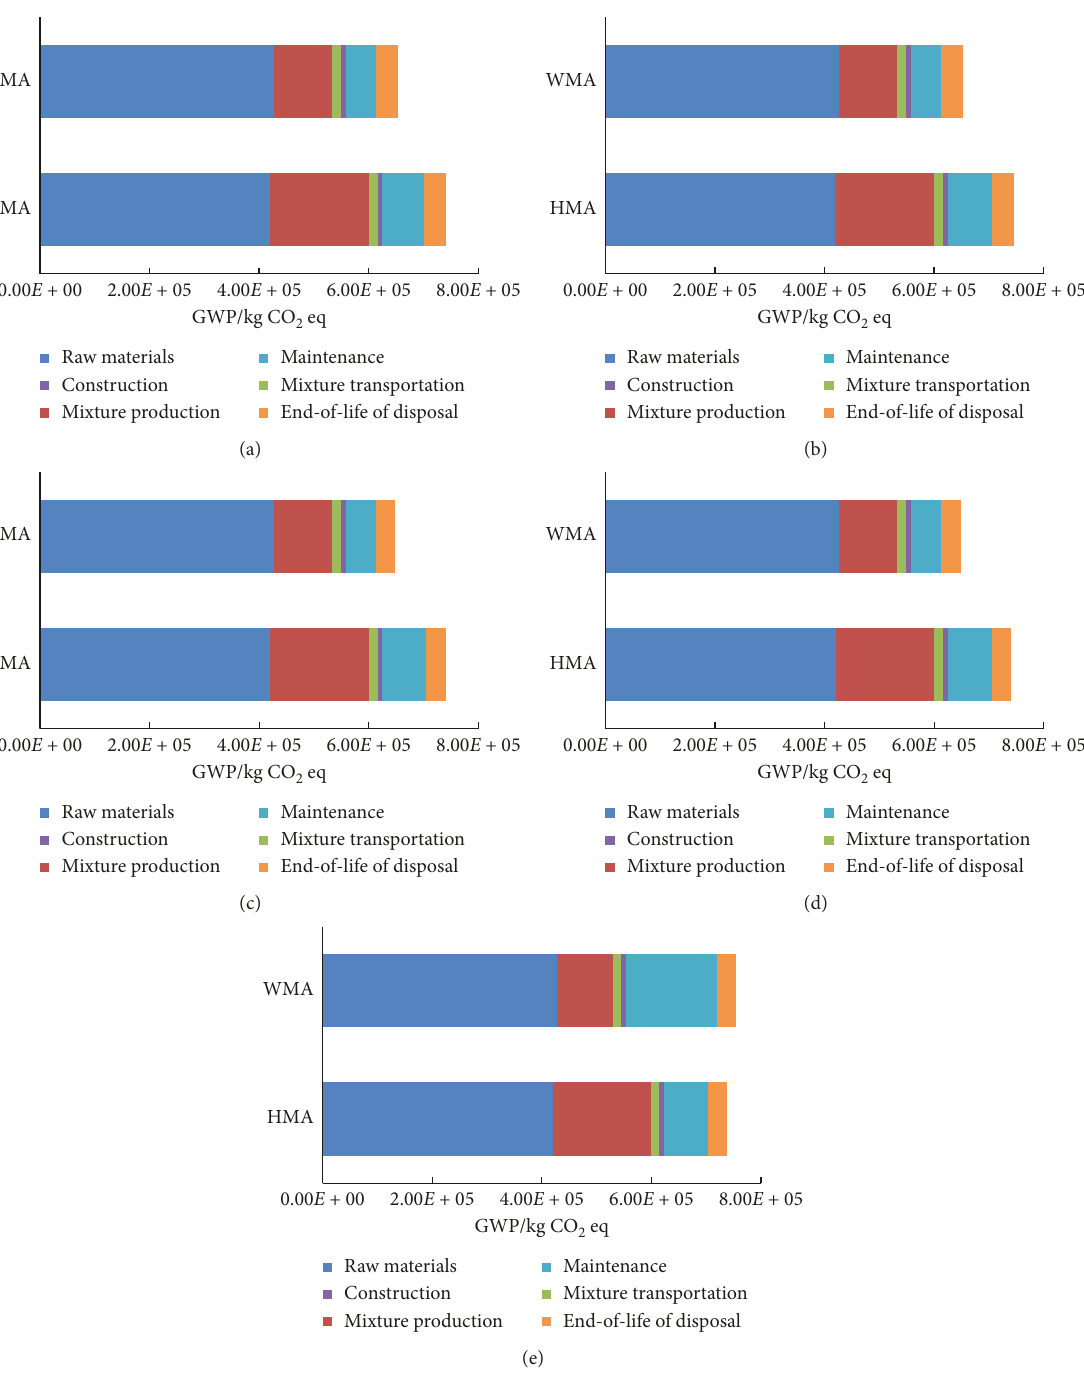
Figure 5: The GWP impacts of HMA and WMA pavements for five cases: (a) case 1; (b) case 2; (c) case 3; (d) case 4; and (e) case